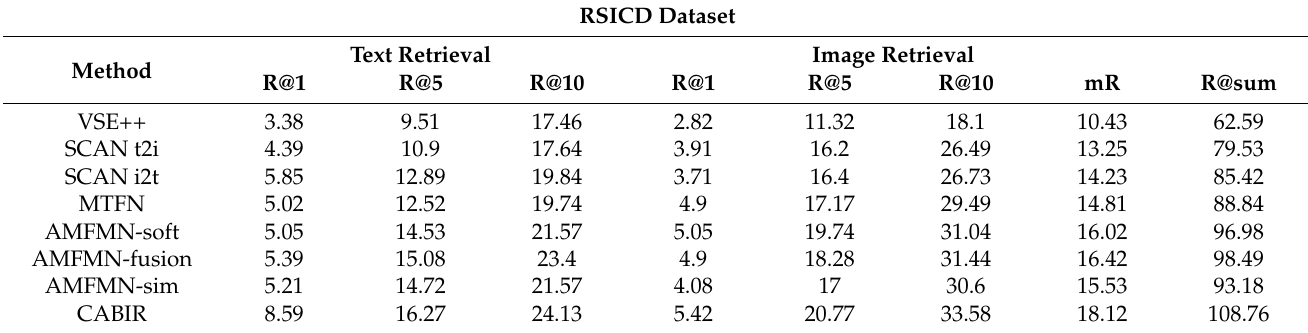
Table 1. Comparison of the results of all models on the dataset